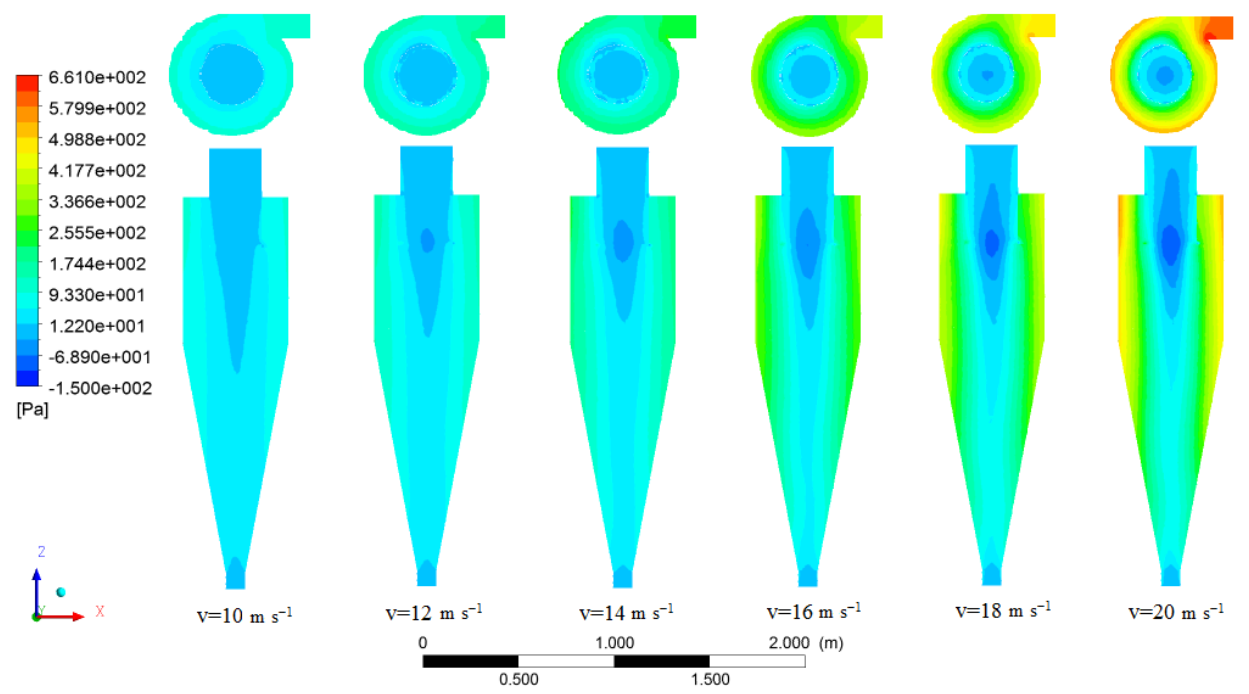
Figure 15. Static pressure contour in various inlet velocities. Additionally, the pressure drops plots in six various heights of cyclones (l/d = 0, l/d = 0.18, l/d = 0.36, l/d = 0.54, l/d = 0.72, l/d = 0.9) are illustrated in Figure 16. Zhou et al. indicated that increasing the inlet velocity increases the pressure